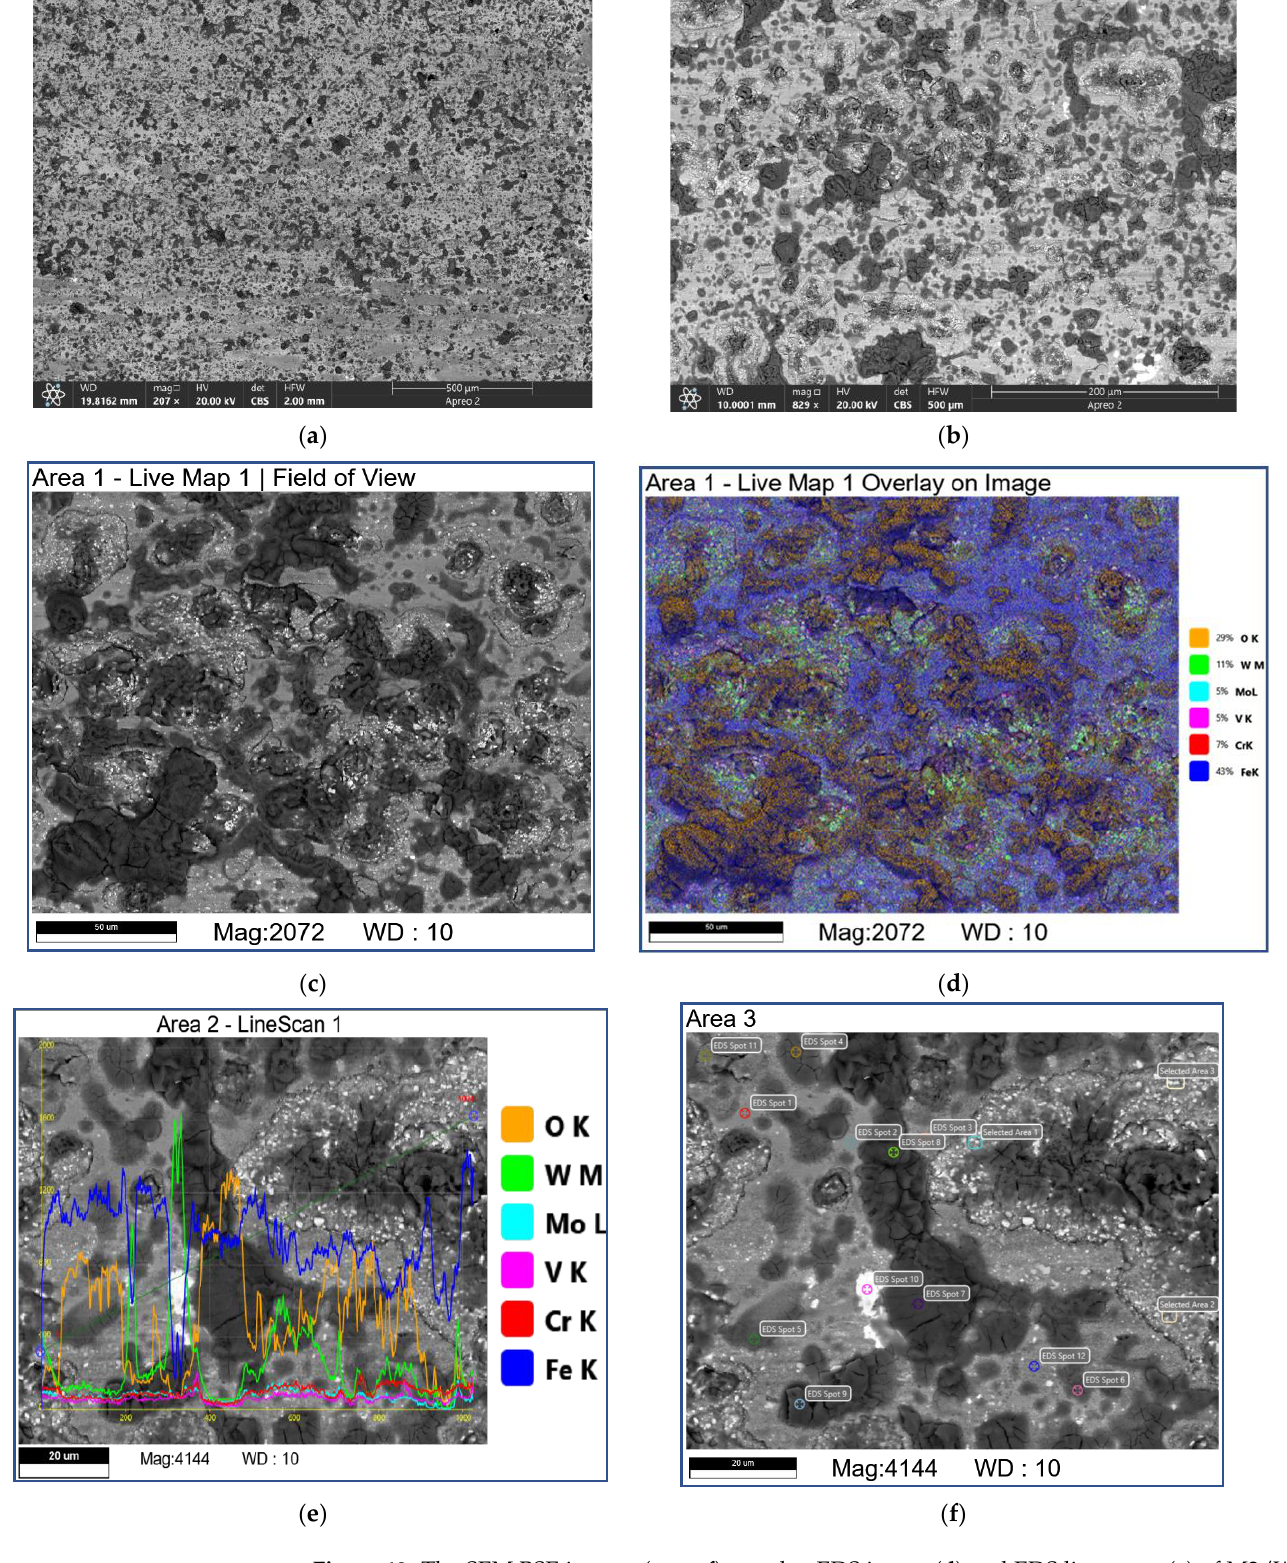
Figure 12. The SEM BSE images ( a – c , e , f ), overlay EDS image ( d ) and EDS line scans ( e ) of M2/W coating worn surface. Data presented for specimens after sliding speed of 3.6 m/s. Numbers on ( f ) indicate probe zones for which EDS elemental concentrations were determined indicated in Table 5.